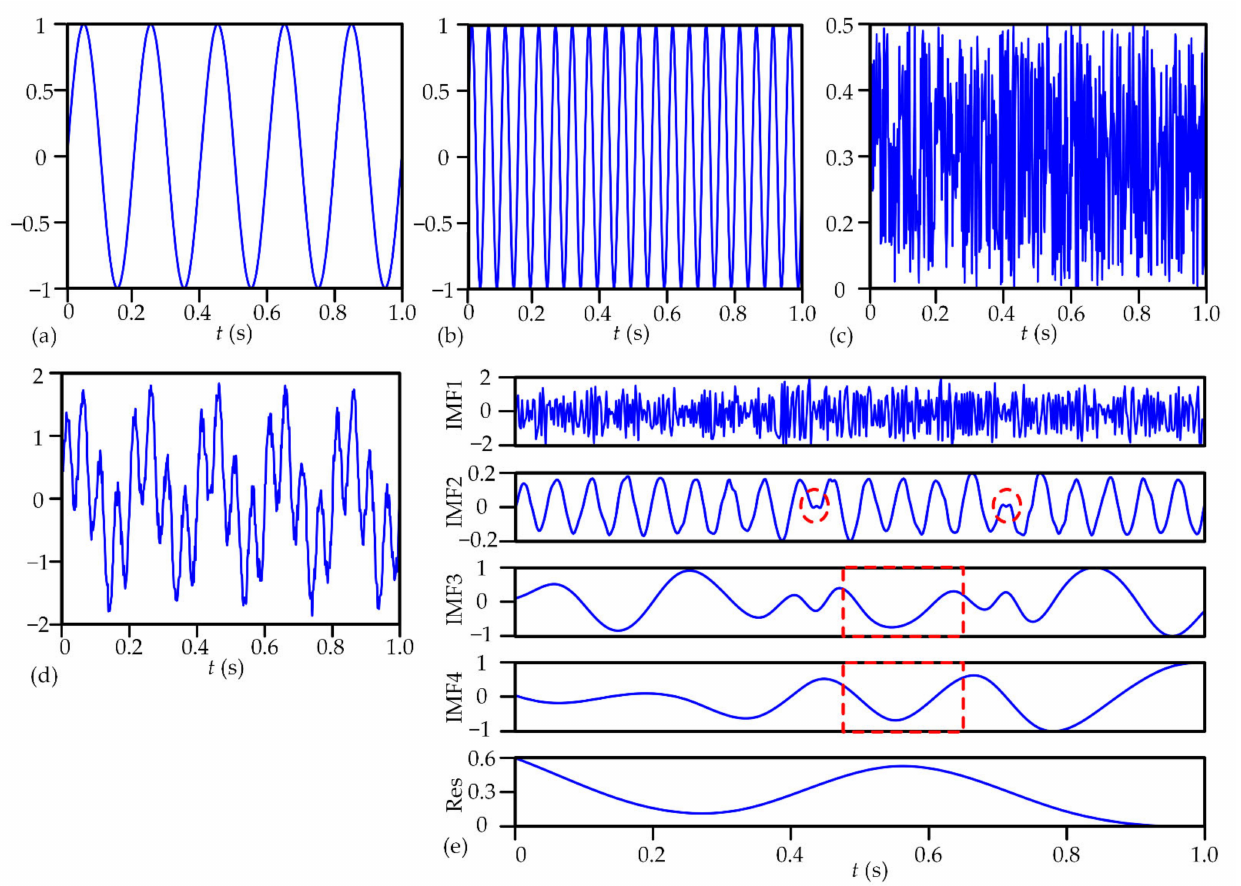
Figure 3. EMD decomposition case (unit: Pa). ( a ) Low-frequency sine wave with a frequency of 10 Hz; ( b ) A high-frequency sine wave with a frequency of 40 Hz, and ( c ) White noise with an amplitude of 0.5. The three waveforms are superimposed to obtain ( d ). ( e ) Shows IMF1, IMF2, IMF3, IMF4 and the residual